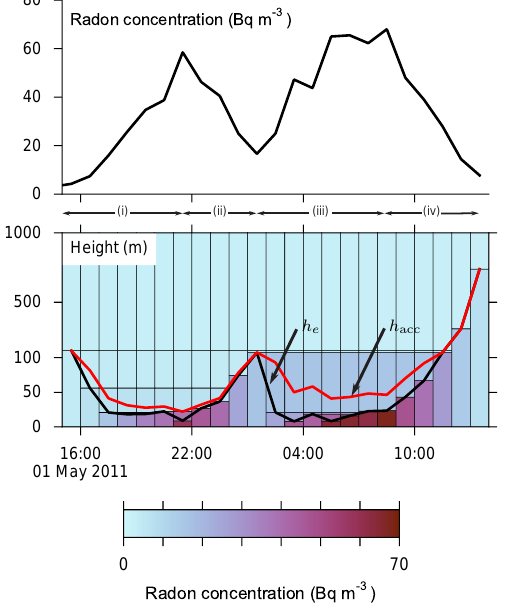
Fig. 3. An illustration of the procedure for deriving the mixing height from one night of observations. The observed radon concen- tration (top panel) can be divided up into four time periods: (i) accu- mulation into a shallow stable layer, (ii) a period of mixing during which low-radon air is mixed down from above, (iii) a second accu- mulation period, and (iv) bottom-up mixing following sunrise and the establishment of buoyancy-driven turbulence. The box model in the lower panel is used to quantitatively interpret the radon con- centration to derive the equivalent mixing height, h e , which differs from the accumulation equivalent mixing height, h acc , from Eq. (5). The state of the box model is indicated with shading. Local time (UTC+10) is used here, and in the following